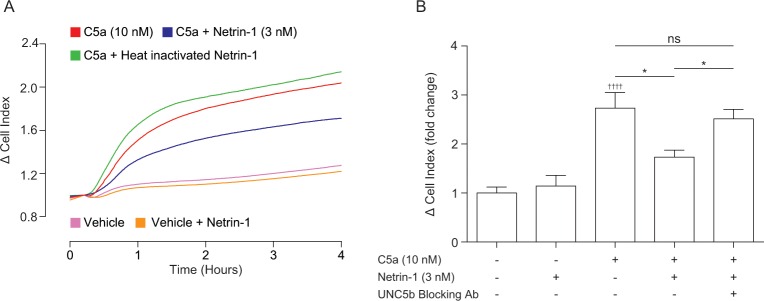
Activation of UNC5b by fully folded netrin-1 is required for inhibition of C5a induced primary macrophage chemotaxis.(A) BMDMs were incubated with either vehicle, 3 nM netrin-1, or 3 nM heat inactivated netrin-1 (heated to 75°C for 25 min) for 45 min at 37°C, 5% CO2 prior to being placed into the upper chamber of a CIM-16 plate (1x105 cells/well). They were then allowed to migrate towards for 4 hours at 37°C, 5% CO2 towards vehicle or 10 nM C5a. (B) BMDMs were incubated with either vehicle, 3 nM netrin-1 alone or 3 nM netrin-1 in the presence of an UNC5b blocking antibody (10 μg/ml) for for 45 min at 37°C, 5% CO2 prior to being placed into the upper chamber of a CIM-16 plate (1x105 cells/well). Cells were then allowed to migrate for 4 hours at 37°C, 5% CO2 towards vehicle or 10 nM C5a. Chemotaxis was quantified by Δ CI analysis. Data are mean + SEM, n = 4 biological replicates with 3–4 technical replicates per condition. Statistical analysis was conducted by one-way ANOVA with Dunnett’s multiple comparisons correction. ns P > 0.05, * P < 0.05, for indicated comparisons. †††† P < 0.0001, compared to the respective vehicle control.